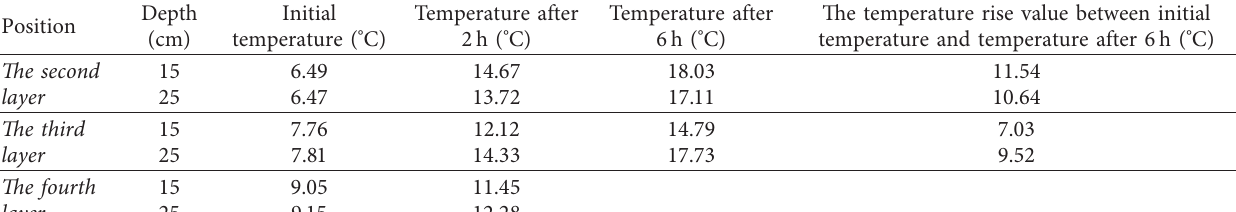
Table 8: Temperature rise value of the second, third, and fourth layers under two burial